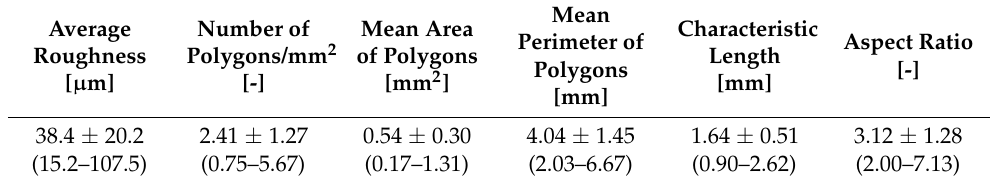
Table 1. Results of skin replica surface analysis: average roughness and watershed